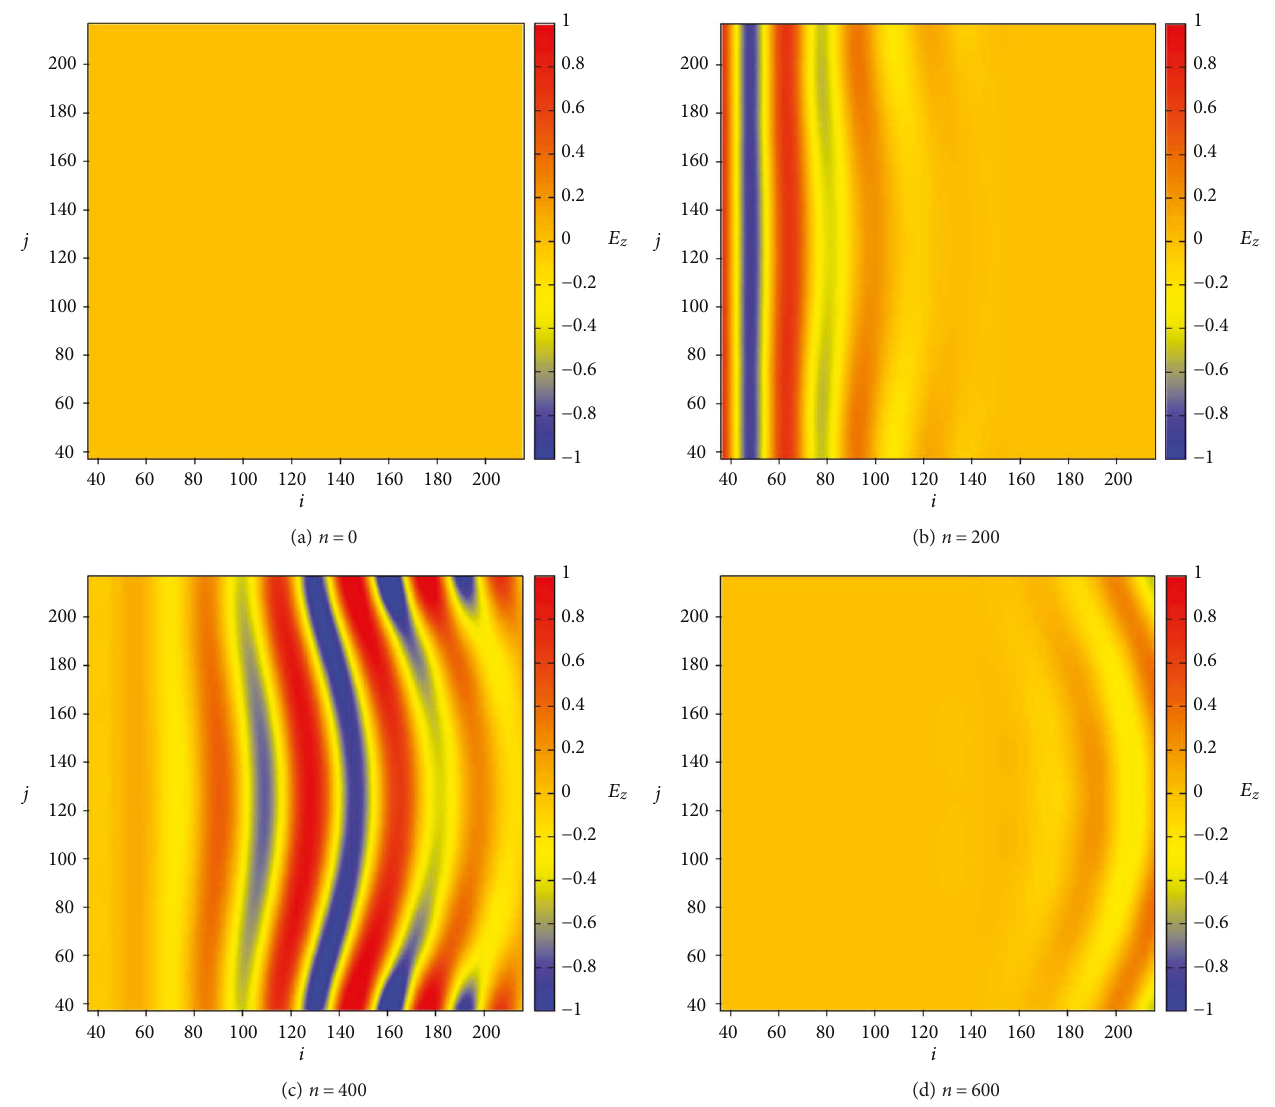
Figure 13: Time evolution of the intensity of the electric fi eld, in volts/meter, across the computational domain, for the inhomogeneous case where incident wave frequency is set to f =10GHz, central electron density is set to n in to ν =500 × 10 6